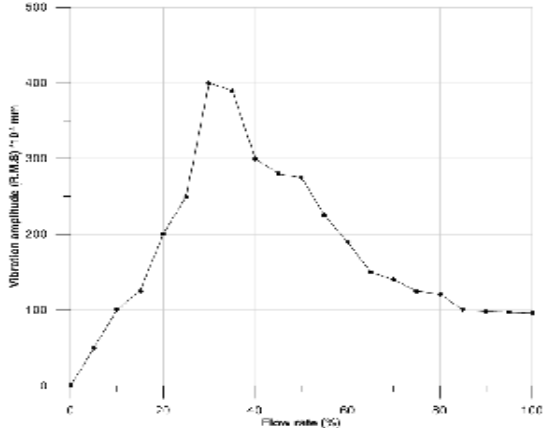
Fig. 12.Vibration amplitude of globe valve versus flow rate cross the valve. [Experimental